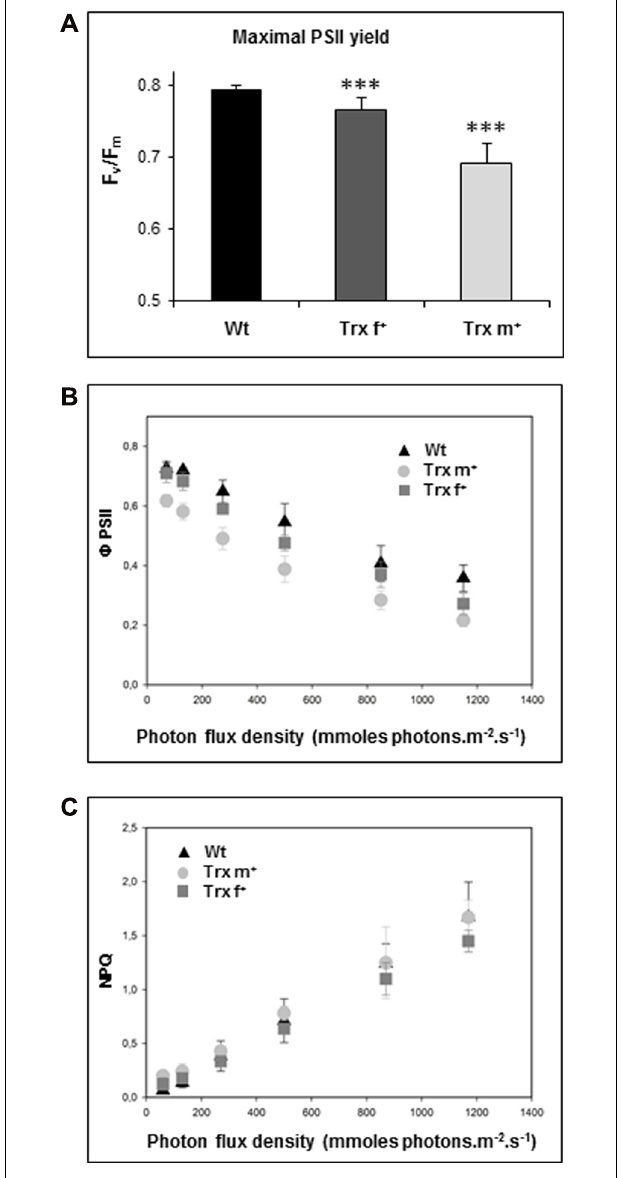
FIGURE 2 | Photosynthetic fluorescence parameters of transplastomic tobacco plants overexpressingTrx f orTrx m. (A) Maximal photosystem II photochemical efficiency in tobacco plants ( F v / F m ). (B) Effective photosystem II yield ( (cid:2) PSII). (C) Non-photochemical quenching (NPQ). Light response curves are shown for (cid:2) PSII (B) and NPQ (C) . Measurements were achieved in leaves from 35-day-oldWt and transplastomic tobacco plants grown in standard conditions. Data are mean values ± SD from at least five independent measurements per genotype. Wt, wild-type;Trx f + andTrx m + , plants overexpressingTrx f orTrx m, respectively. ***Significantly different fromWt with p < 0.001 ( t